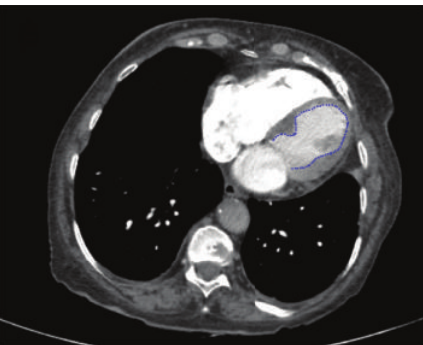
Figure 3: CT angiography showing the integrity of a thin ventricular septum with anterior and apical hypokinesia (apical ballooning pattern) of the left ventricle and also the right ventricle.